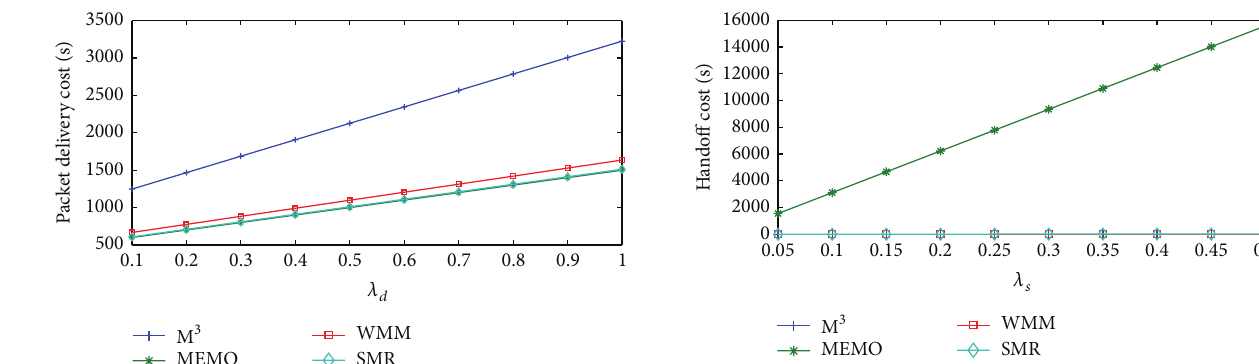
Figure 8: Packet delivery cost/sec versus 𝜆 𝑑 .